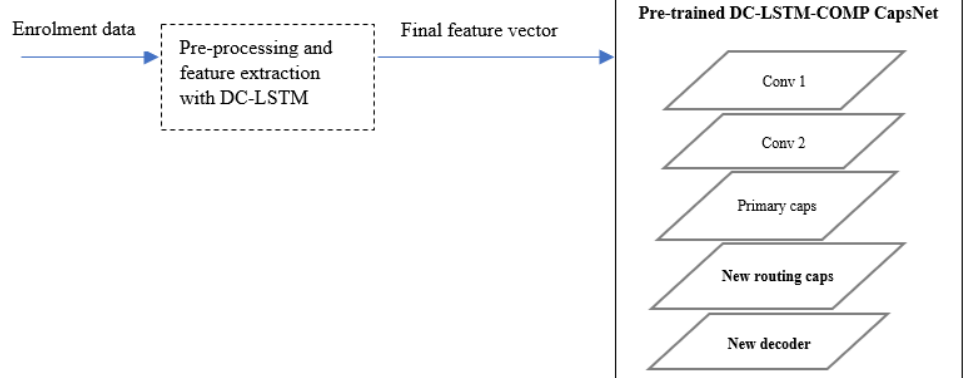
Figure 4. Block diagram of speaker verification of the proposed DC-LSTM-COMP CapsNet model in the enrolment phase.